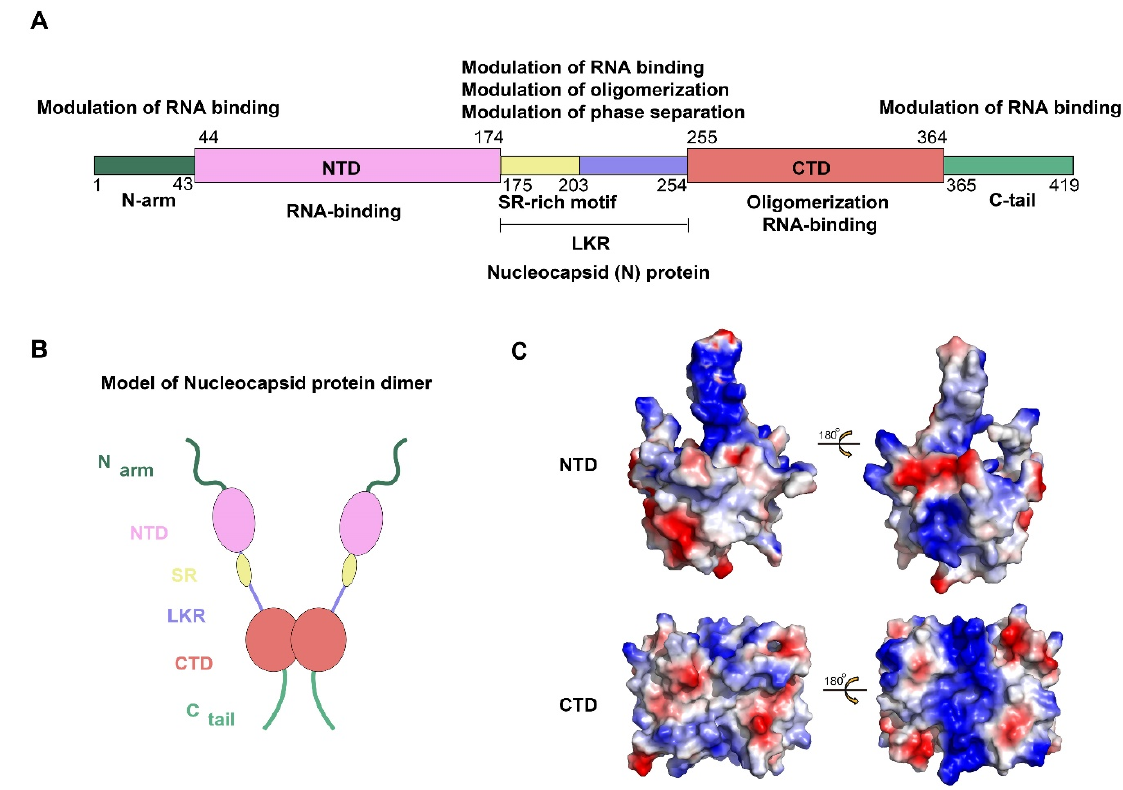
Figure 1. Structural overview of the SARS-CoV-2 N protein. ( A , B ) Schematic of the SARS-CoV-2 N protein modular organization. The three intrinsically disordered regions, including the N-arm, central Ser/Arg(SR)-rich flexible linker region (LKR) and C-tail, and the N-terminal domain (NTD) and C-terminal domain (CTD) are illustrated. ( C ) Electrostatic surface of the SARS-CoV-2 N-NTD (PDB ID 6YI3) and N-CTD (PDB ID 7CE0). Blue denotes positive charge potential, while red indicates negative charge potential. All structural figures were prepared using PyMOL.